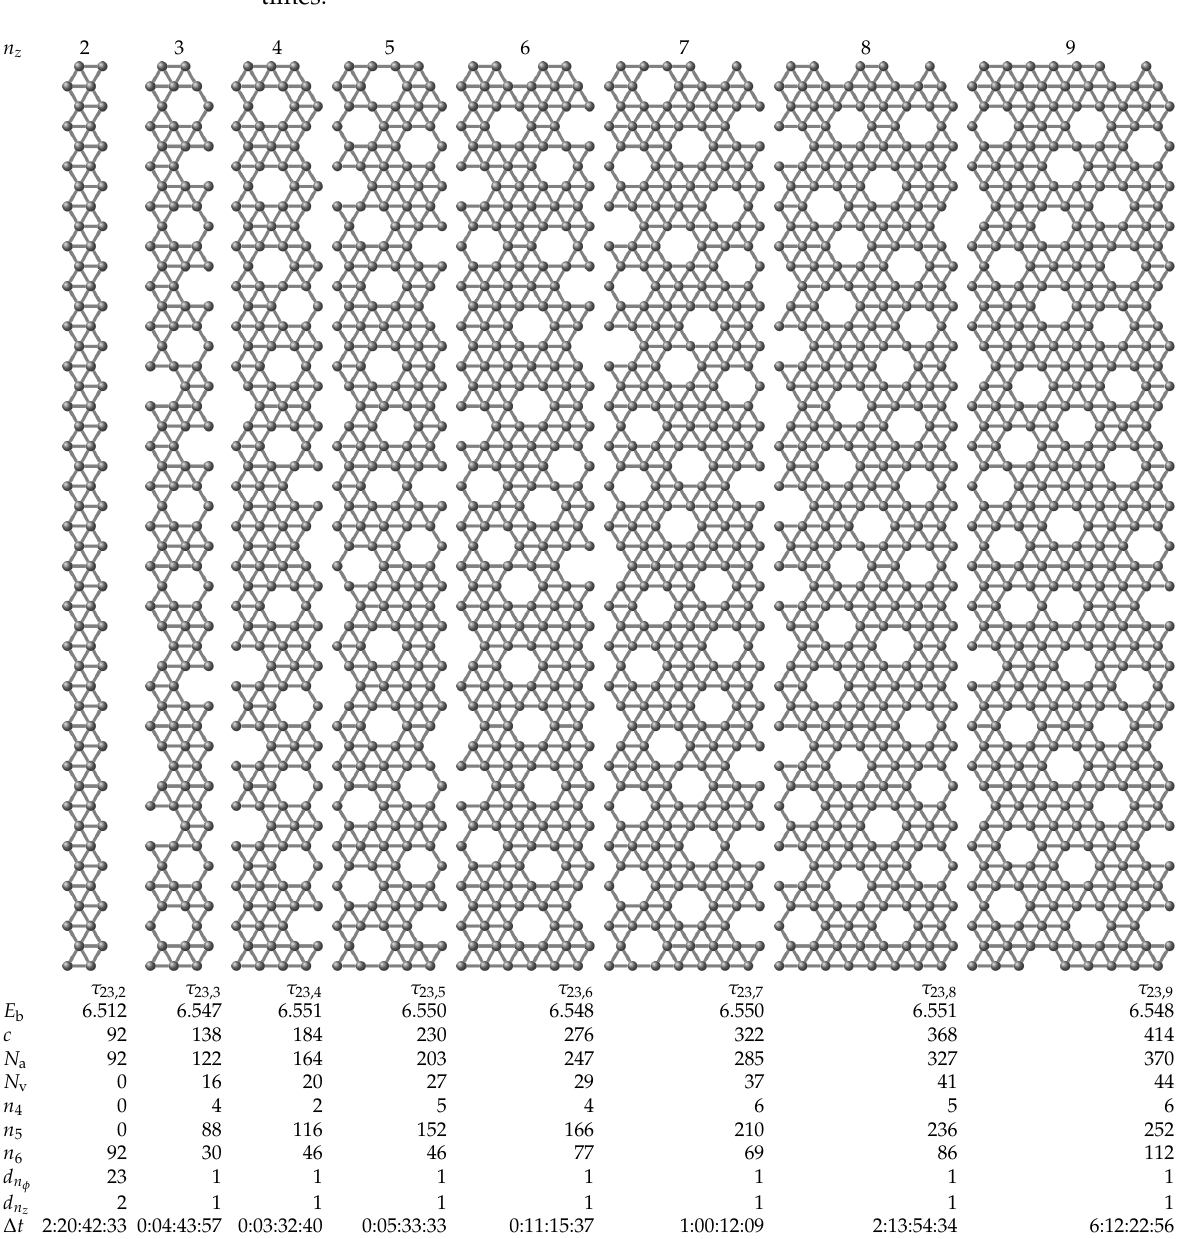
Figure 1. Fragments of boron sheets that, if rolled into nanotubes, give the most stable BNTs that were obtained in our evolutionary computations. The unit cell of each BNT is defined by two parameters ( n φ , n z ) , where n φ = 23 and n z is specified above each stripe. Below each stripe, several parameters are listed that characterize each nanotube (see text). The binding energy per atom, E b , is given in units of eV/atom. The holes in the nanotubes are vacancies in the hexagonal structure wrapped on a cylinder to form a nanotube. The density of holes can be calculated using the formula η = N v / c , where c = N a + N v . The values of the calculation time, ∆ t , are presented using